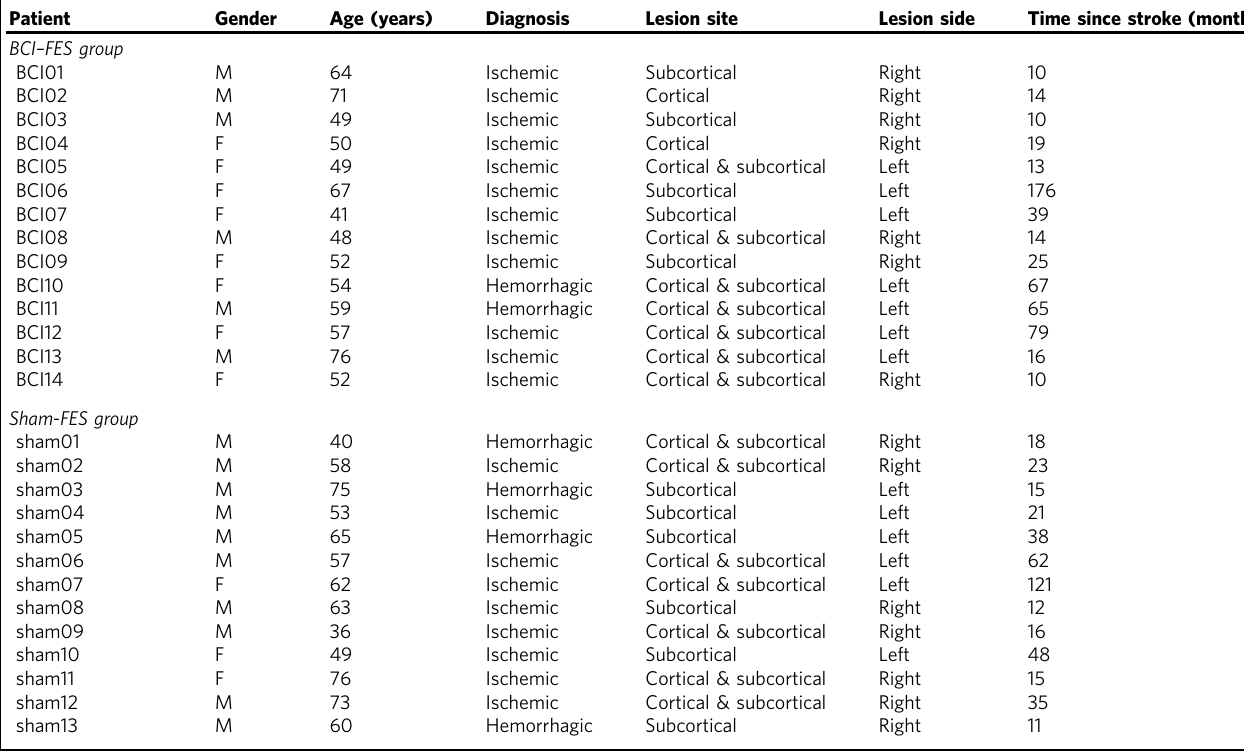
Table 4 Patients ’ characteristics, including lesion etiology Patient